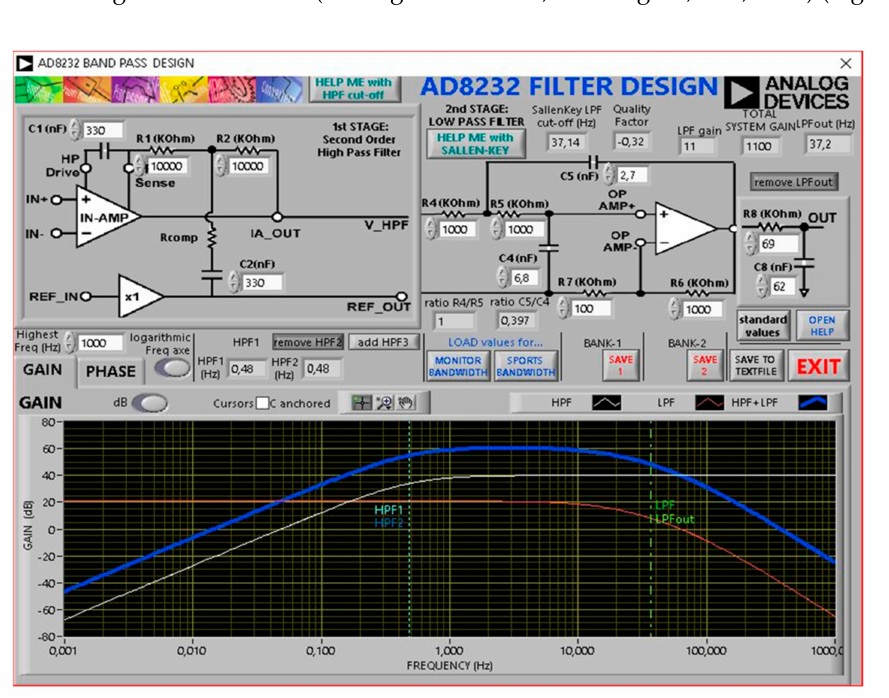
Figure 4. The frequency response plot. The main features of the ECG acquisition block: 1 Channel; 500 samples/s; 115 kBaud/s; Right leg drive (RLD) circuit. The ADuM5241 digital isolator (Analog Devices Inc., Wilm- ington, MA, USA) is employed for human safety and noise protection. ADS8325 16-bit ADC converts the analog output of the AD8232 to a digital